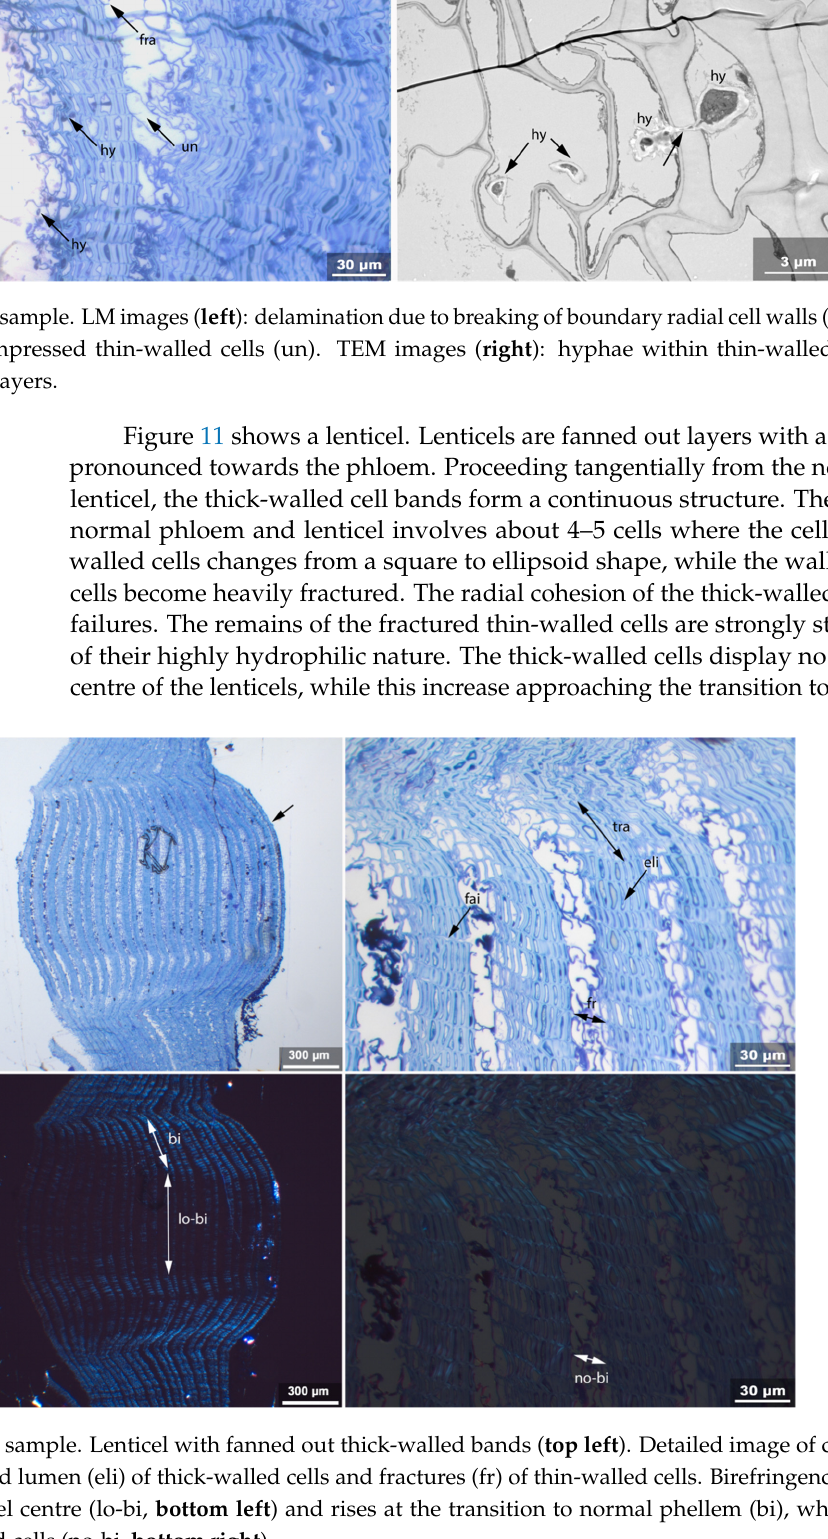
13 of 30 Figure 9. Reference sample. TEM images of thick-walled and thin-walled cells. The compound middle lamella (CML) is thicker in radial direction (ra) than tangential direction (ta) in thick-walled cell bands (top left). In tangential direction, interruptions of composite middle lamella are present (in, bottom left). There is a clearly pronounced corner (cor) at the transition between thick- and thin-walled bands. Details of thin-walled cell (upper right) and thick-walled cell (bottom